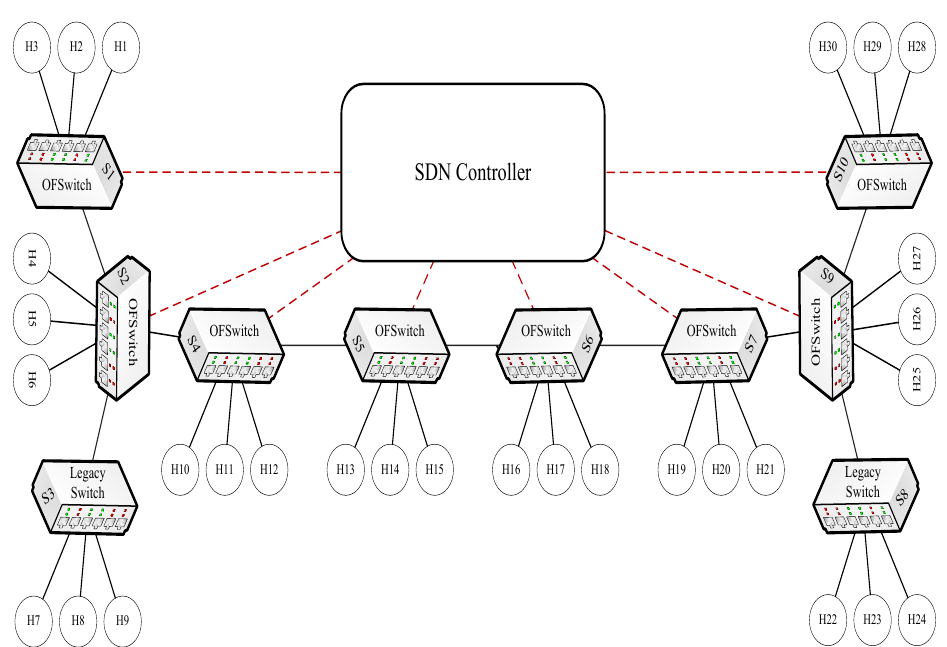
Figure 11. Network Scenario 4: Hybrid.